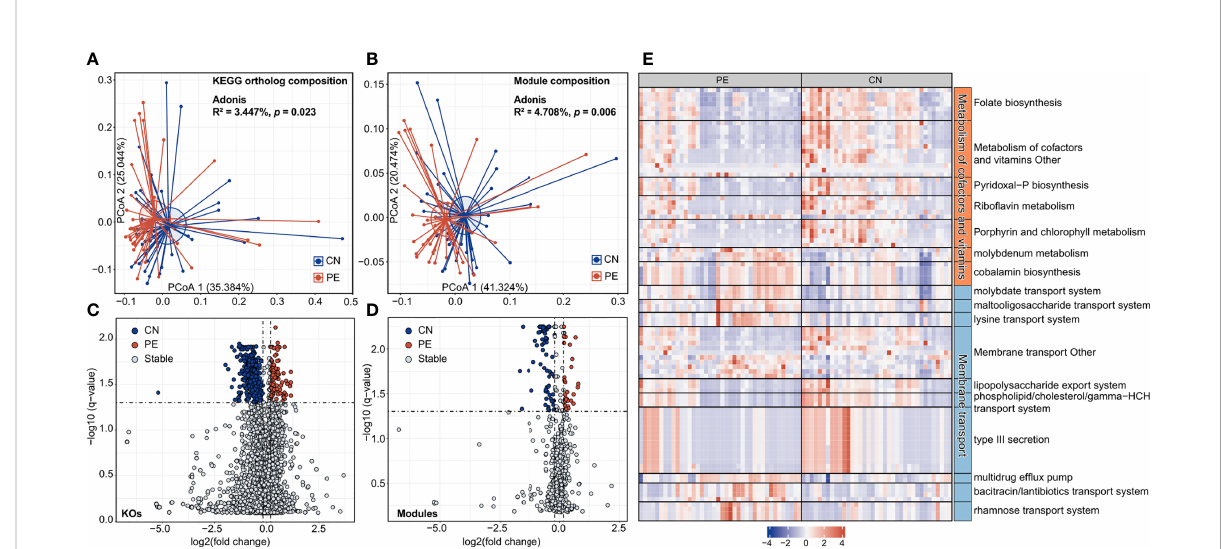
FIGURE 4 Functional comparison of the gut microbiome. (A, B) PCoA analysis of Bray-Curtis distance based on the functional composition of gut microbiota at the KO (A) and module (B) levels. The location of samples (represented by nodes) in the fi rst two principal coordinates is shown. Lines connect samples in the same group, and circles cover samples near the center of gravity for each group. (C, D) Volcano plots show the fold change vs. q -values for the KOs (C) and modules (D) . The X-axis shows the ratio (log2 transformed) of function abundance in PE patients compared with that in healthy controls. The Y-axis shows the q -value (-log10 transformed) of a function. The functions that were enriched in PE and control subjects are shown in red and blue points, respectively. (E) A heatmap showing the abundance of PE-associated KOs involved in the metabolism of cofactors and vitamins and membrane transport pathways. Each column represents an individual and each row represents a KO. The pathway categories of the KOs are grouped and the detailed information of these KOs are shown in Table